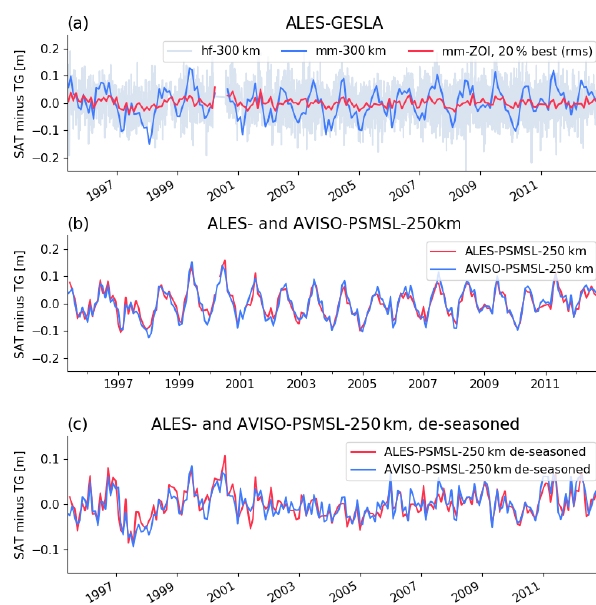
Figure 2. Shown are “SAT minus TG” time series for different datasets and configurations for the TG in Fig. 1a. (a) Monthly mean (mm) time series for ALES–GESLA when all SLAs are averaged in a 300km radius (blue) and when SLAs are comprised of the 20% most representative anomalies based on the rms SAT-TG between the altimetry and TG (red). The grey line denotes the underlying high- frequency time series. (b) Monthly mean differenced time series for ALES–PSMSL and AVISO–PSMSL, which are based on a 250km radius selection of SLAs. (c) Same as (b) but with the annual and semi-annual signals